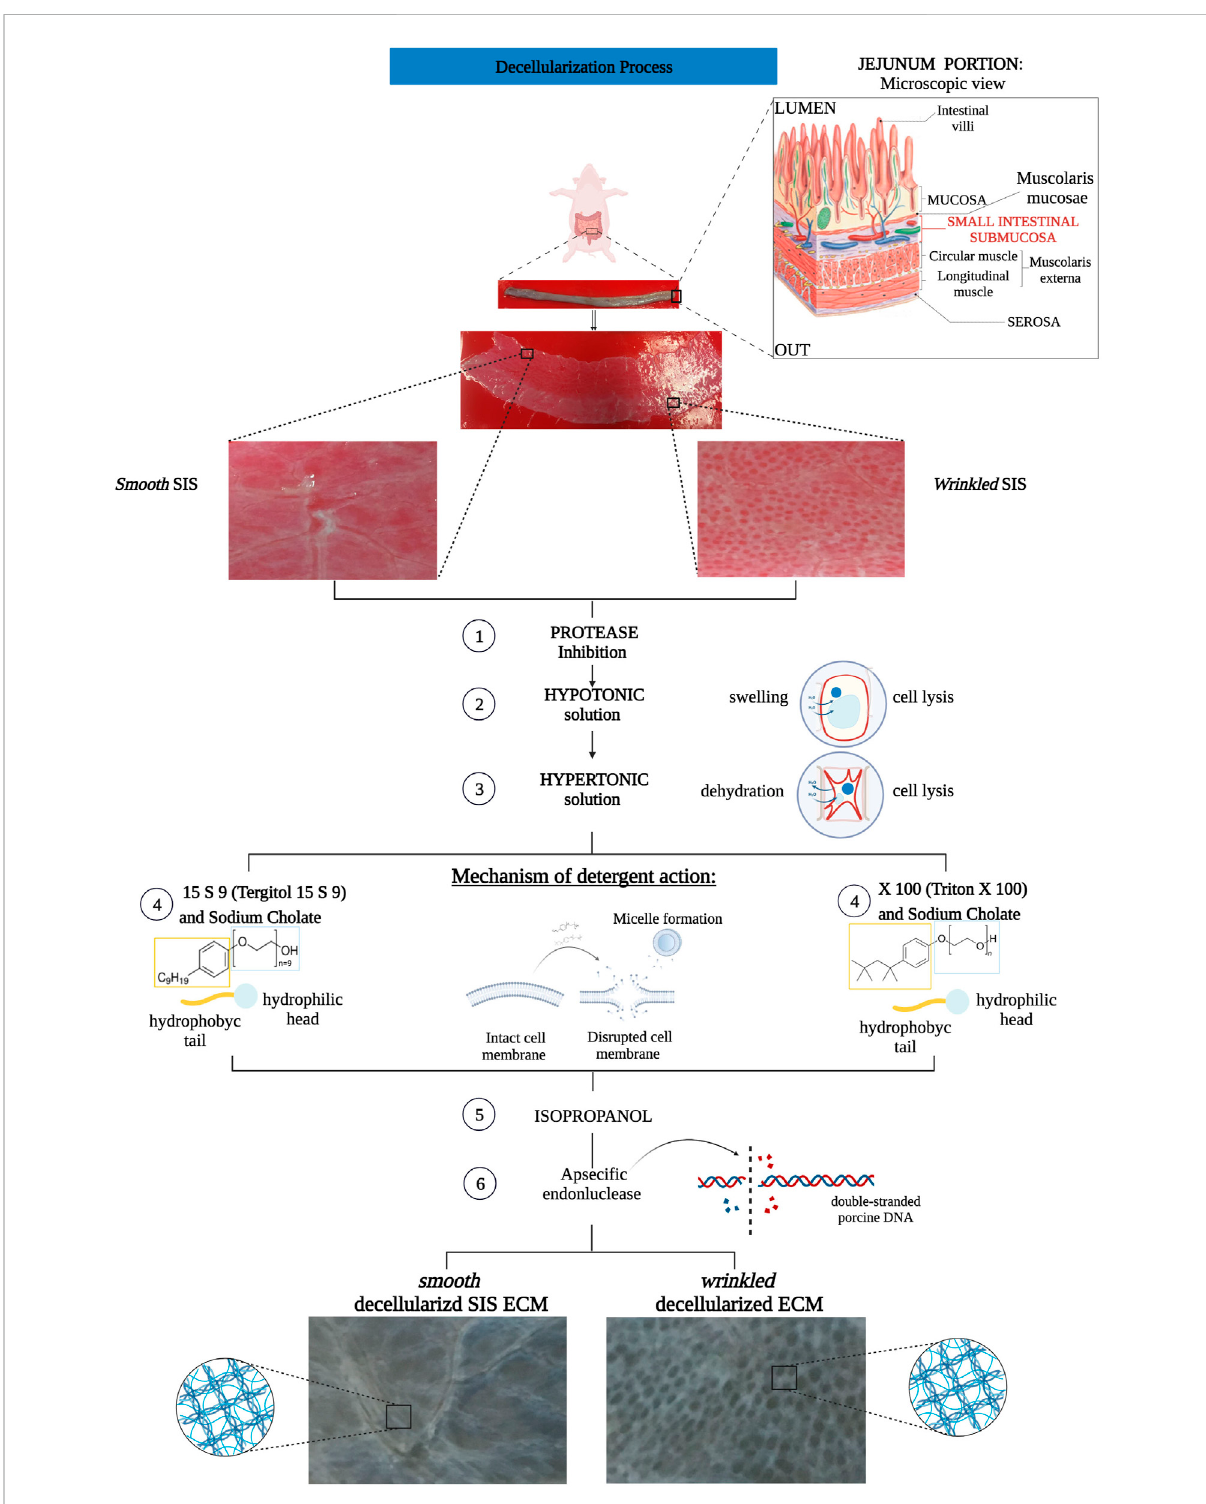
FIGURE 1 Flow chart decellularization process with Triton X 100 and Tergitol 15 S 9 of smooth and wrinkled SIS. The tubular tissue of SIS was extracted between themucosa (internally) and theserosa (externally). The tube was opened and separated into itstwo different regions, smooth andwrinkled, and subjected to decellularization processes. Both involved a pre-treatment with a solution that inhibited the action of proteases to block the enzyme activity that degrades the ECM. Subsequently, the use of hypo- and hyper-tonic solutions, with different salt concentrations, ensured